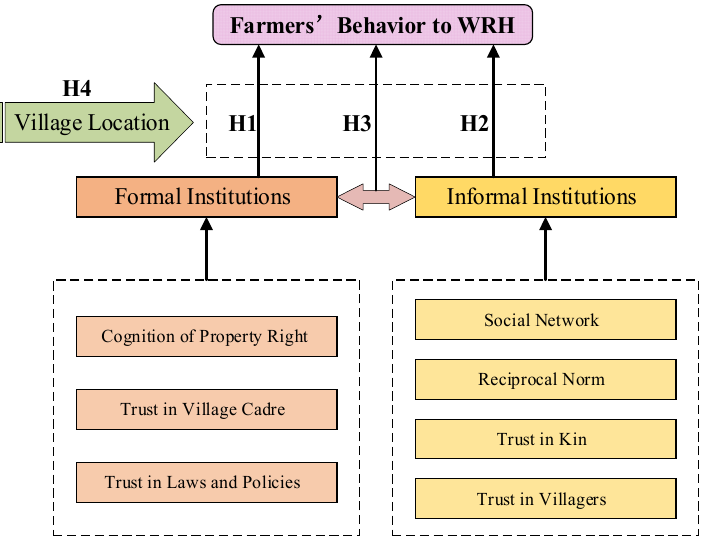
Figure 1. Theoretical analysis framework.